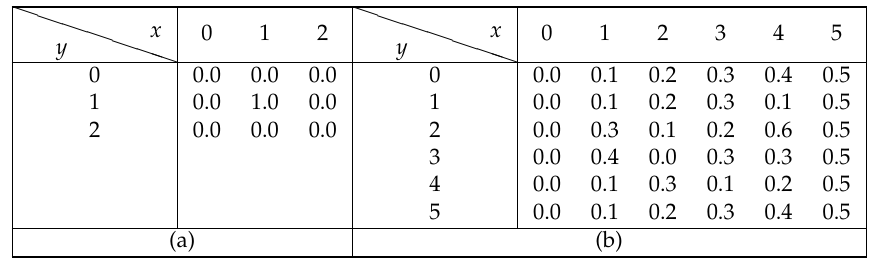
Figure 9. ( a ) The surface constructed with the original data. ( b ) The fractal interpolation surface. Table 3. The interpolated data (a) of Qian’s work and (b) of Wang’s work.